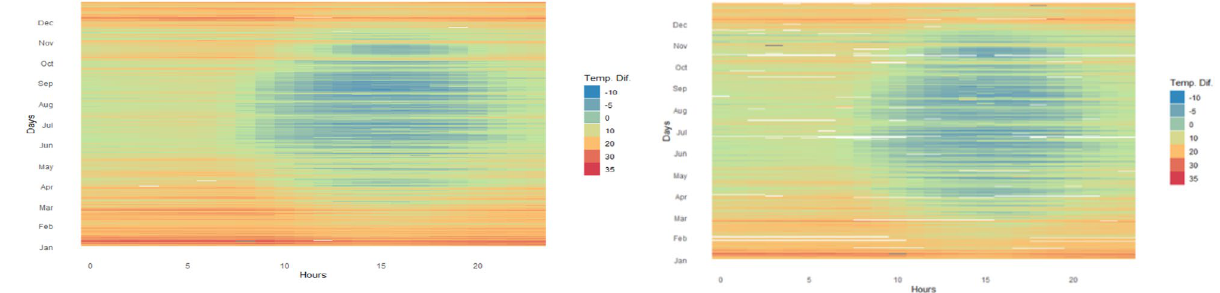
Figure 4. The heat map representation of Δt (tin–tout): Δt for the house with AIRC of 665 Bq/m 3 (left), Δt for the house with AIRC of 65 Bq/m 3 (right). Each “pixel” represents the average hourly Δt. The figure was made using R (3.6.3) software (www. rstud io. com).